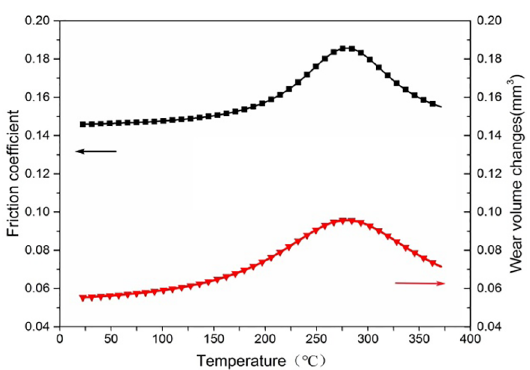
Figure 12. The coefficient of friction and worn volume for the 9Cr18Mo sample as functions of temperature